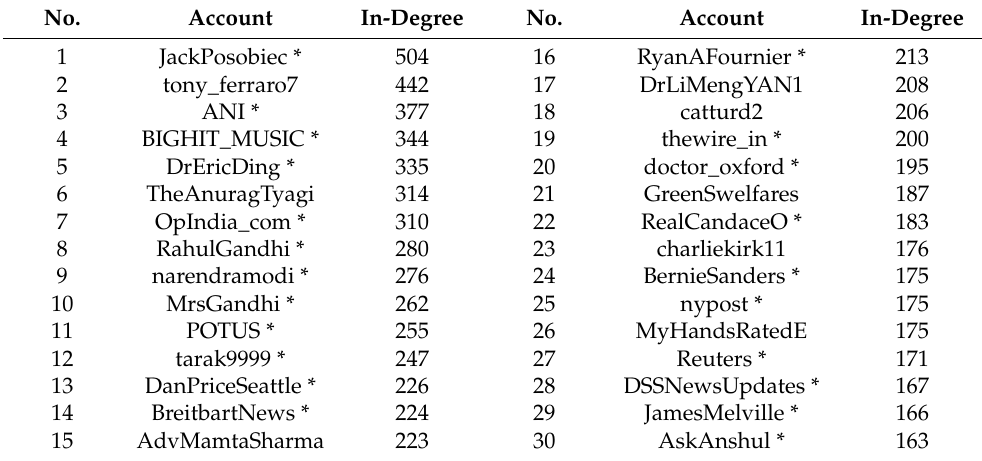
Table 4. Top 30 twitter accounts by in-degree.